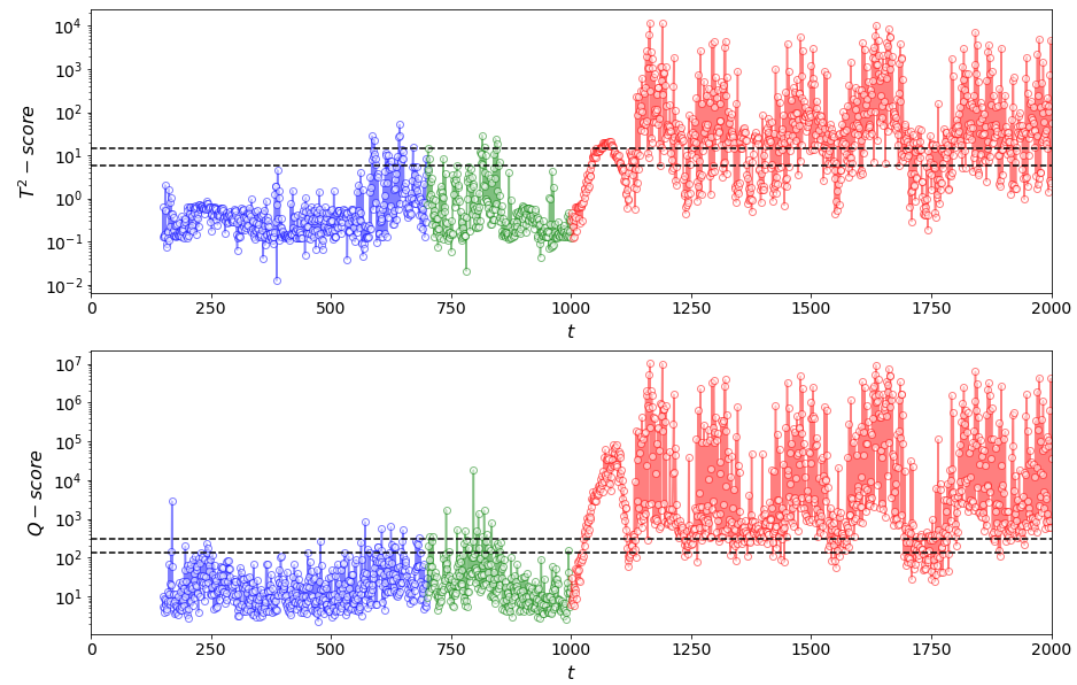
Figure 16. T 2 ( top ) and Q ( bottom ) process monitoring charts of simulated dataset for a window length of 150 time steps using Method II. NOC data are shown in blue (up to index 749), validation data in green (indices 750–999) and test (fault) data in red (indices 1000–2000).